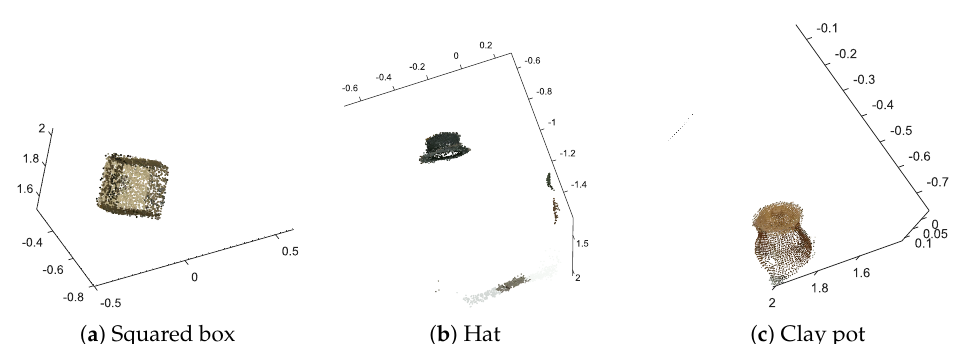
Figure 12. Qualitative reconstructions results using filtered DeepMatching. ( a ) Shows the reconstruction of a squared box, ( b ) shows the reconstruction of a hat, and ( c ) shows the reconstruction of a clay pot. Table 5. Angle errors of the squared box. Angle Errors ( ◦